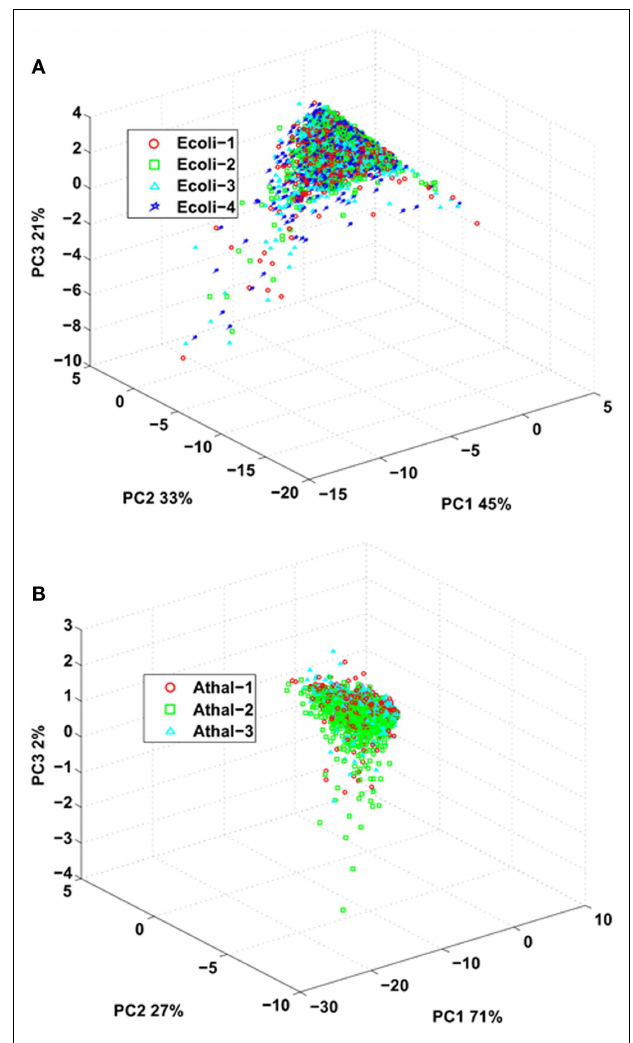
FIGURE 2 | Principal component analysis of spectral counts, Mascot ions score, and total ion current (derived from MS/MS) from common peptides identified over all replicates from (A) E. coli and (B) Arabidopsis